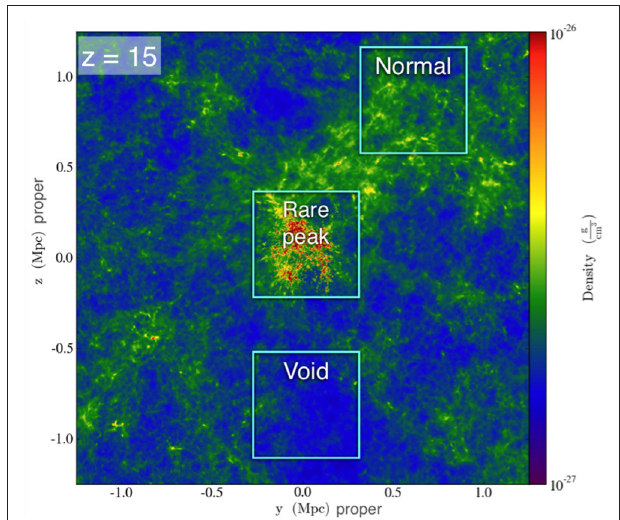
FIGURE 8 | The Renaissance Simulations calculate star and galaxy formation in three regions with AMR and the full physics suite of the Birth of a Galaxy simulations: a high density region “Rare peak,” a region of average density “Normal,” and a low density region “Void.” The box size is 40 cMpc on a side, which at z = 15 is a few proper Mpc on a